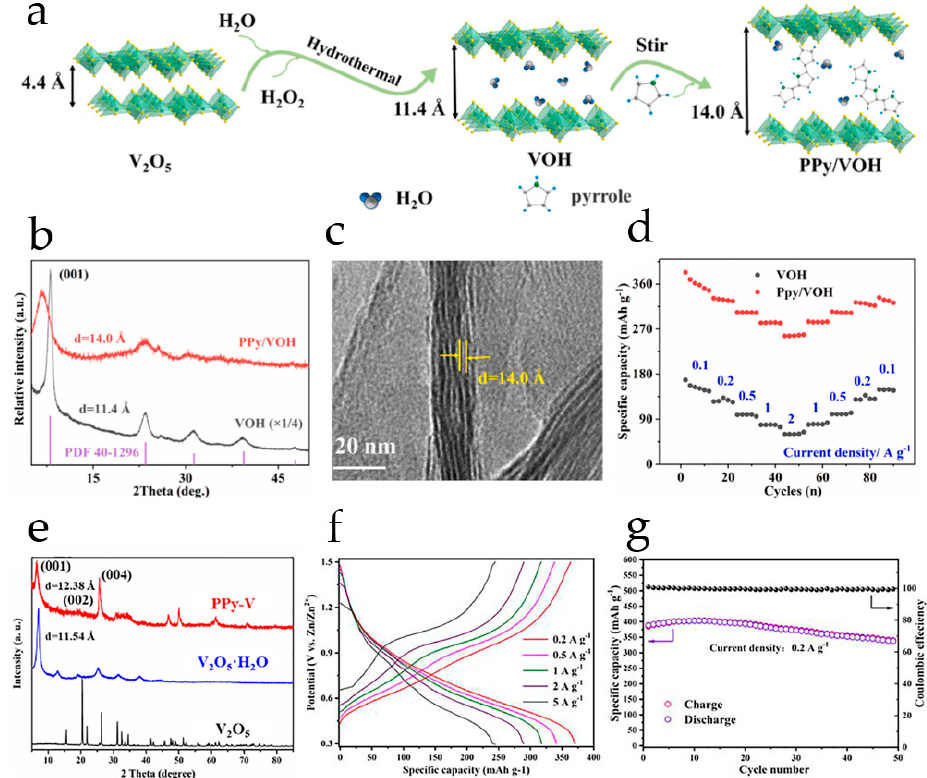
Figure 4. ( a ) Scheme of the PPy/VOH composite synthesis [85]; ( b ) XRD patterns of VOH and PPy/VOH [85]; ( c ) HRTEM image of PPy/VOH [85]; ( d ) Rate capability of VOH and PPy/VOH